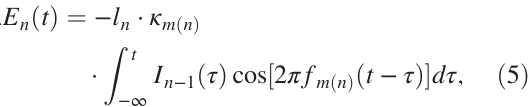
FIG. 2. Plot of the numerically calculated wavelength and amplitude of a wakefield excited by an on-axis electron bunch in a single-mode DLW. The different colors correspond to different thicknesses of the dielectric